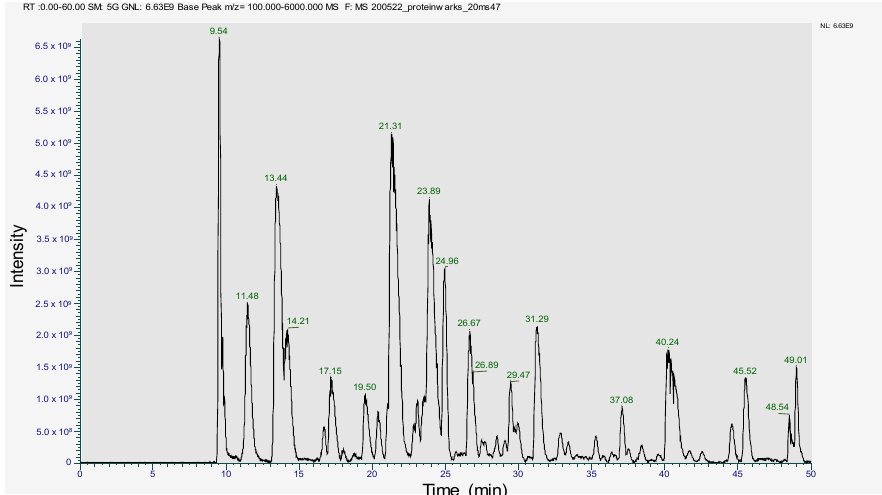
Table 2. Mascot search results.